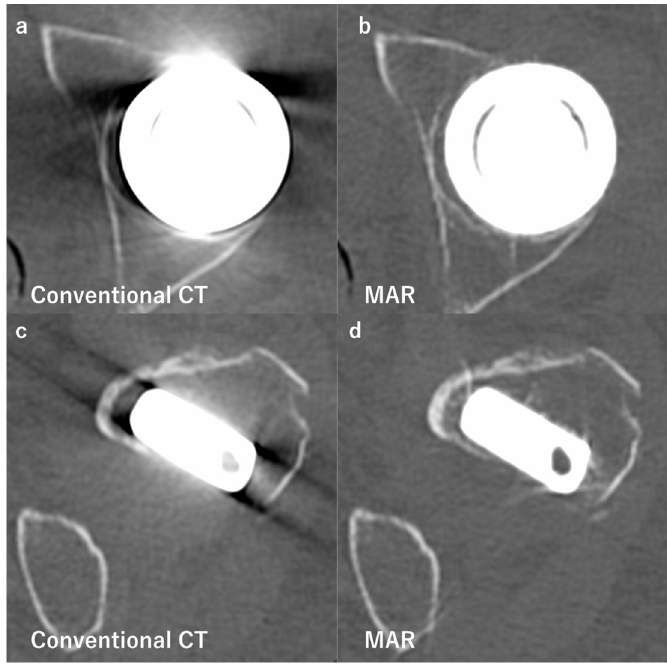
Figure 4. Comparison of conventional computed tomography (CT) and images reconstructed with the metal artifact reduction algorithm (MAR). Axial images of a patient after hemiarthroplasty of the hip. Images ( a , b ) show the bipolar femoral head, while ( c , d ) show the femoral stem at the level of the minor trochanter. Images ( a , c ) were obtained by conventional CT, and show strong beam hardening, scattering, photon starvation, and edge effects. On the other hand, there are no obvious metal artifacts on images ( b , d ) using MAR. It leads to better visualization of the outlines of the prosthesis.